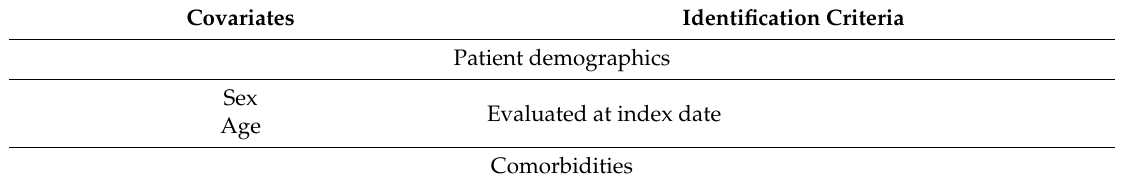
Table A2. List of covariates included in the baseline characterization of incident treatments. Covariates Identification